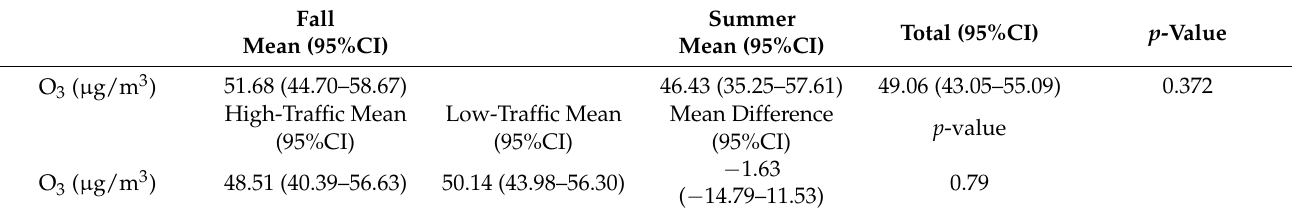
Table 4. Comparison of O 3 Variation by Season and Traffic Density.